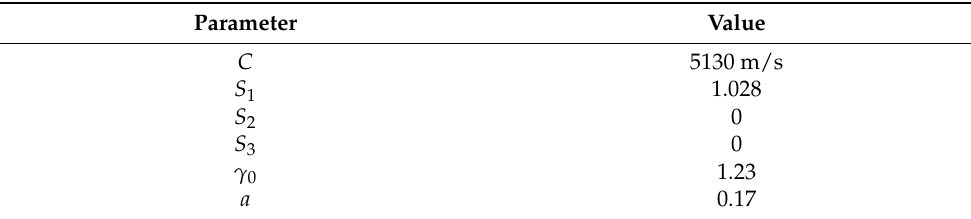
Table 4. Parameters used in Gruneisen EOS for Ti-6Al-4V [9].